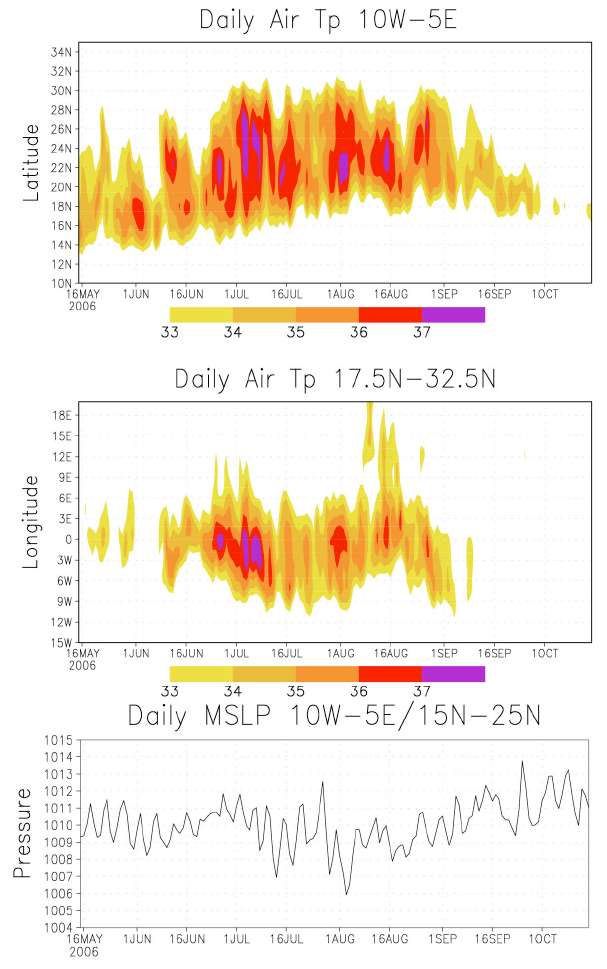
Figure 12. Top: Time-latitude diagram of NCEP daily temperature (°C) at the sigma level 0.995 averaged over the longitudes 10°W-5°E. Middle: Time-longitude diagram of NCEP Fig. 12. Top: Time-latitude diagram of NCEP daily temperature daily temperature (°C) at the sigma level 0.995 averaged over the latitudes 17.5°N-32.5°N. ( ◦ C) at the sigma level 0.995 averaged over the longitudes 10 ◦ W– Bottom: Time series of NCEP daily mean sea level pressure (hPa - 1000) at the sigma level 5 ◦ E. Middle: Time-longitude diagram of NCEP daily temperature ( ◦ C) at the sigma level 0.995 averaged over the latitudes 17.5 ◦ N– 32.5 ◦ N. Bottom: Time series of NCEP daily mean sea level pres- sure (hPa–1000) at the sigma level 0.995 averaged over the domain 15 ◦ N–25 ◦ N/10 ◦ W–5 ◦ E.